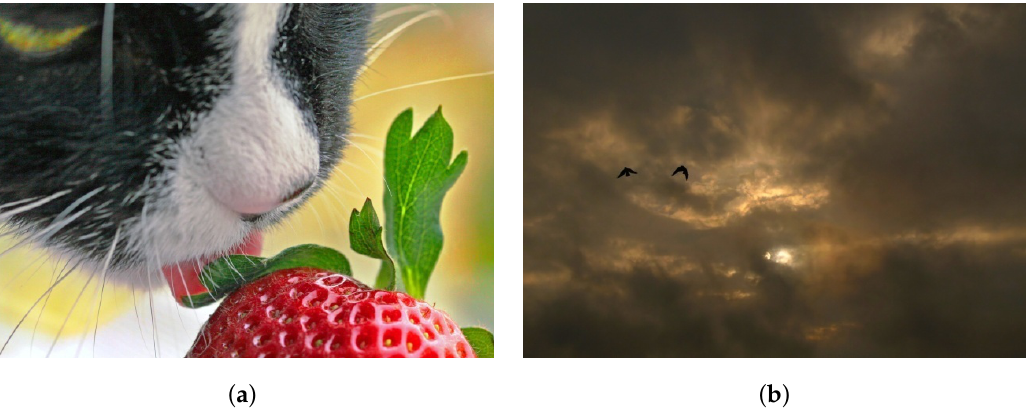
Figure 1. Sample images of ( a ) positive and ( b ) negative